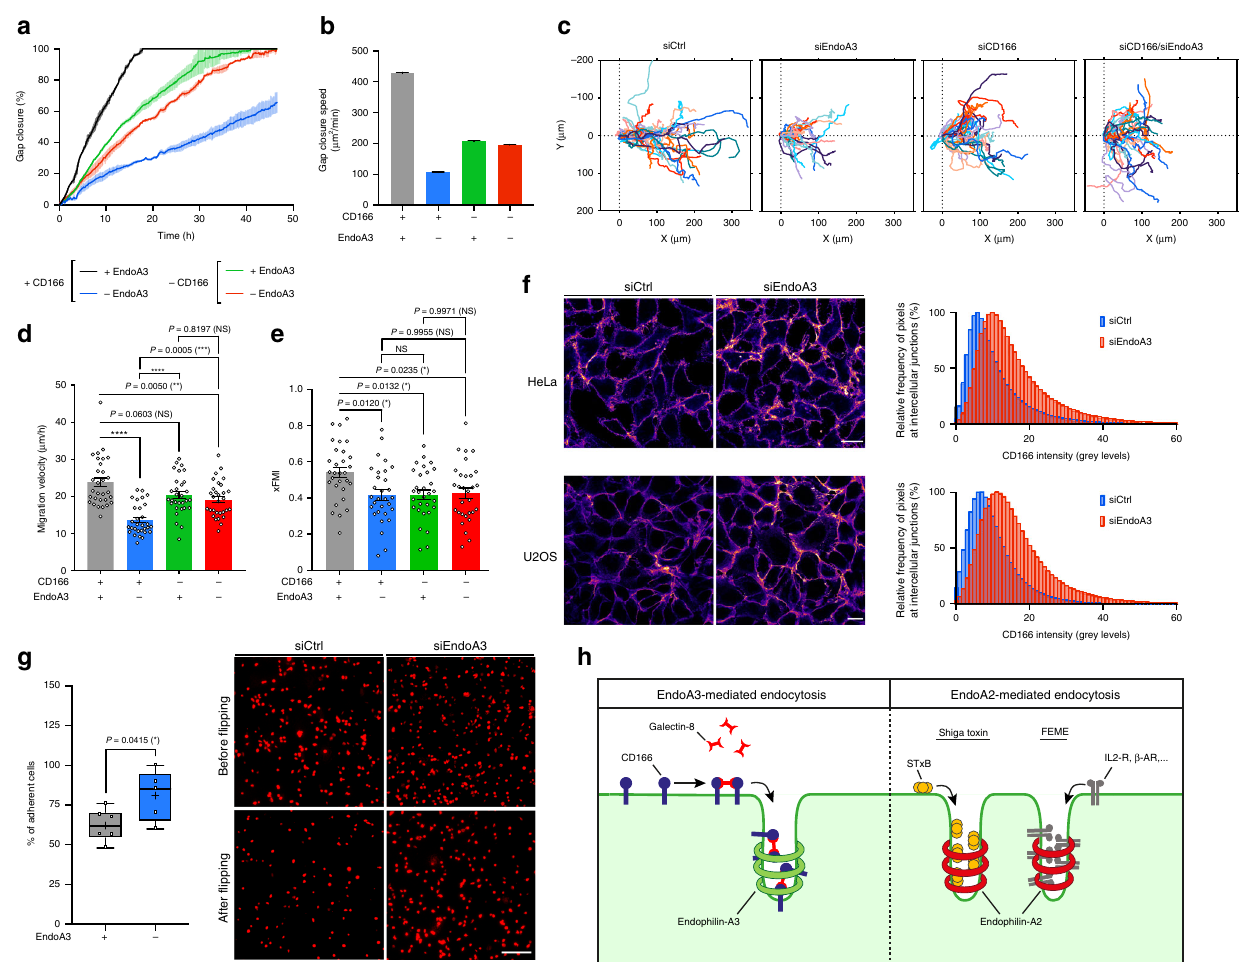
Fig. 4 Modulation of CD166 cell surface abundance by endoA3-dependent endocytosis affects cancer cell adhesive and migratory properties. U2OS ( a – f ) and HeLa ( f , g ) cells. a – e Wound-healing assay on cells treated with negative control (gray), endoA3 (blue), CD166 (green), or combined CD166 and endoA3 (red) siRNAs. See Supplementary Movie 14. a Gap closure over time (percentage of the initial gap area). Intervals, range between two technical replicates ( n = 2). Representative of three independent experiments. b Average gap closure speed, extracted from linear regressions fi tted to curves in ( a ). Representative of three independent experiments. c – e Single-cell tracking at the edge of the wound (800 min). c Accumulated tracks. d Average migration velocity. e Forward migration index along the x- axis (xFMI). n = 30 cells. Three independent experiments. NS not signi fi cant. * P < 0.05, ** P < 0.01, *** P < 0.001, **** P < 0.0001 (ordinary one-way ANOVA, with Tukey ’ s multiple comparison test). Euclidian distance, Supplementary Fig. 10a. f Accumulation of CD166 at intercellular junctions upon endoA3 depletion. Heatmap of anti-CD166 signal in con fl uent monolayers of cells treated with control (siCtrl) or endoA3 (siEndoA3) siRNAs. Histograms, quanti fi cation of junctional fl uorescence intensity ( n = 5 images). Representative of two independent experiments. g , Cell – cell adhesion fl ipping assay (Supplementary Fig. 10h; Methods). Adhesiveness of cells in suspension treated with control (siCtrl) or